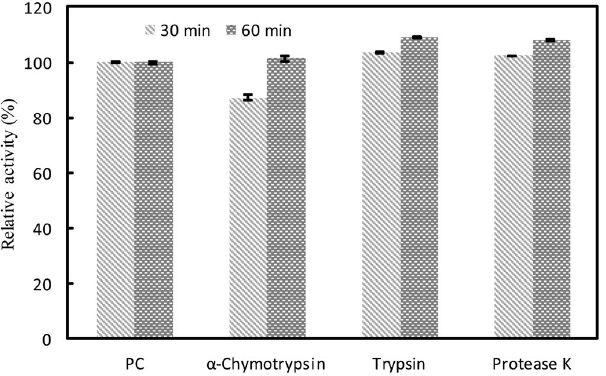
Figure 5. Resistance of AiiK to proteolysis. All experiments were carried out in triplicates. PC stands for positive control, containing 4 μ g/mL AiiK, 50 μ M C 10 -HSL, and 10 mM PBS (pH 7.4), then the reaction was carried out at 45 °C for 10 min.